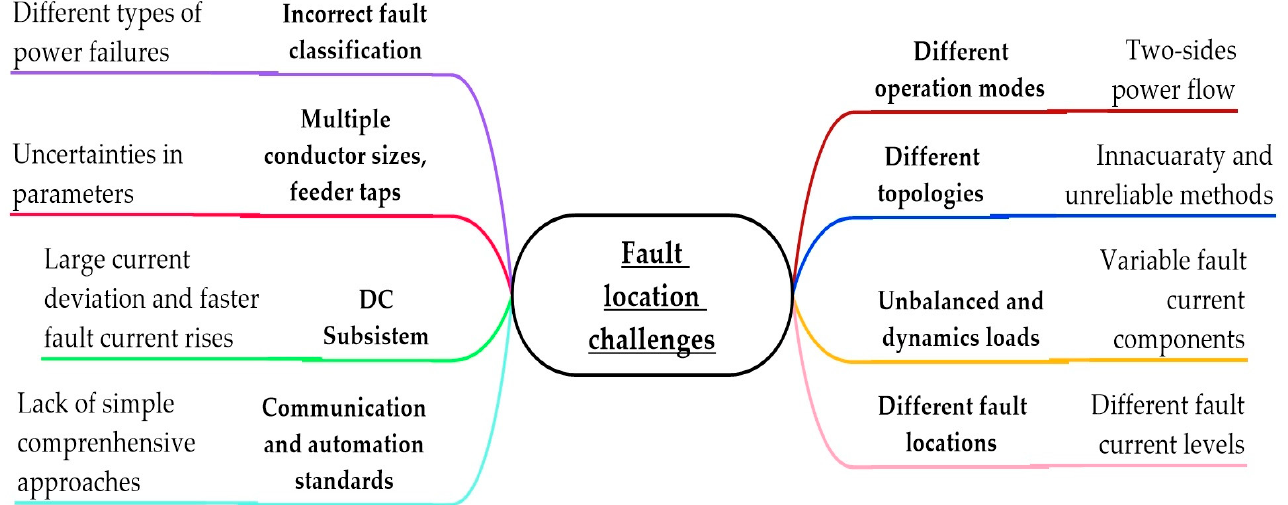
Figure 2. Fault location challenges in SG’s distribution domain [21]. Various authors also discuss various fault location techniques and methods for SGs Table 1. Topics covered in this review. Reference